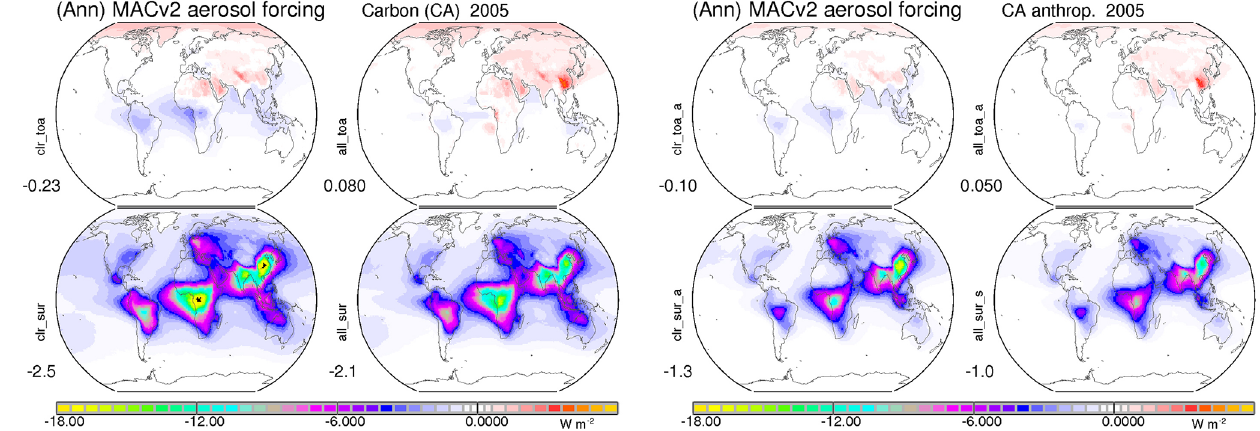
Figure E6. Annual maps for present-day radiative effects of total (left frame) and anthropogenic (right frame) soot (or carbon (BC + OC). Each block displays impacts for clear-sky (left column) and all-sky conditions (right column) at both TOA (top row) and surface (bottom row). Blue colors indicate a cooling (at the surface) and red colors a warming (at the TOA). Values below the labels are global